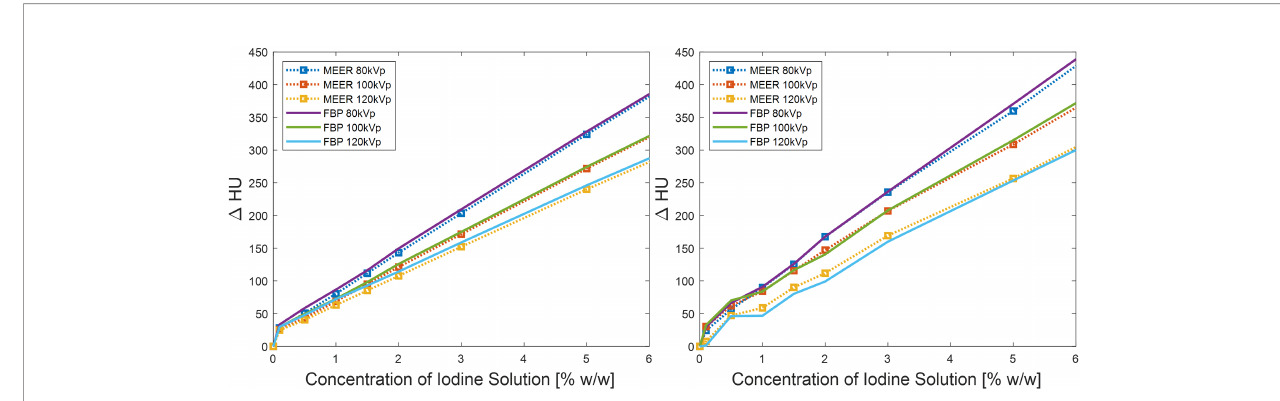
FIGURE 6 | Comparison of contrast enhancements between our method and FBP reconstruction method in simulation study (left) and experimental study (right). Result of 10% iodine concentration not displayed to focus on relevant data range.